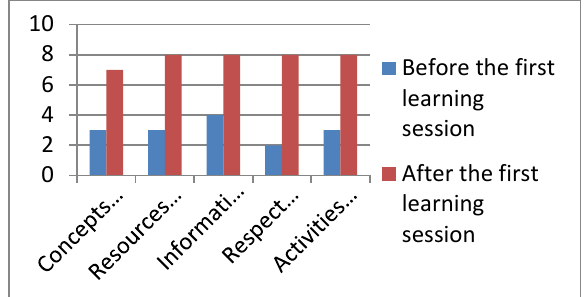
Figure 7. Evaluation